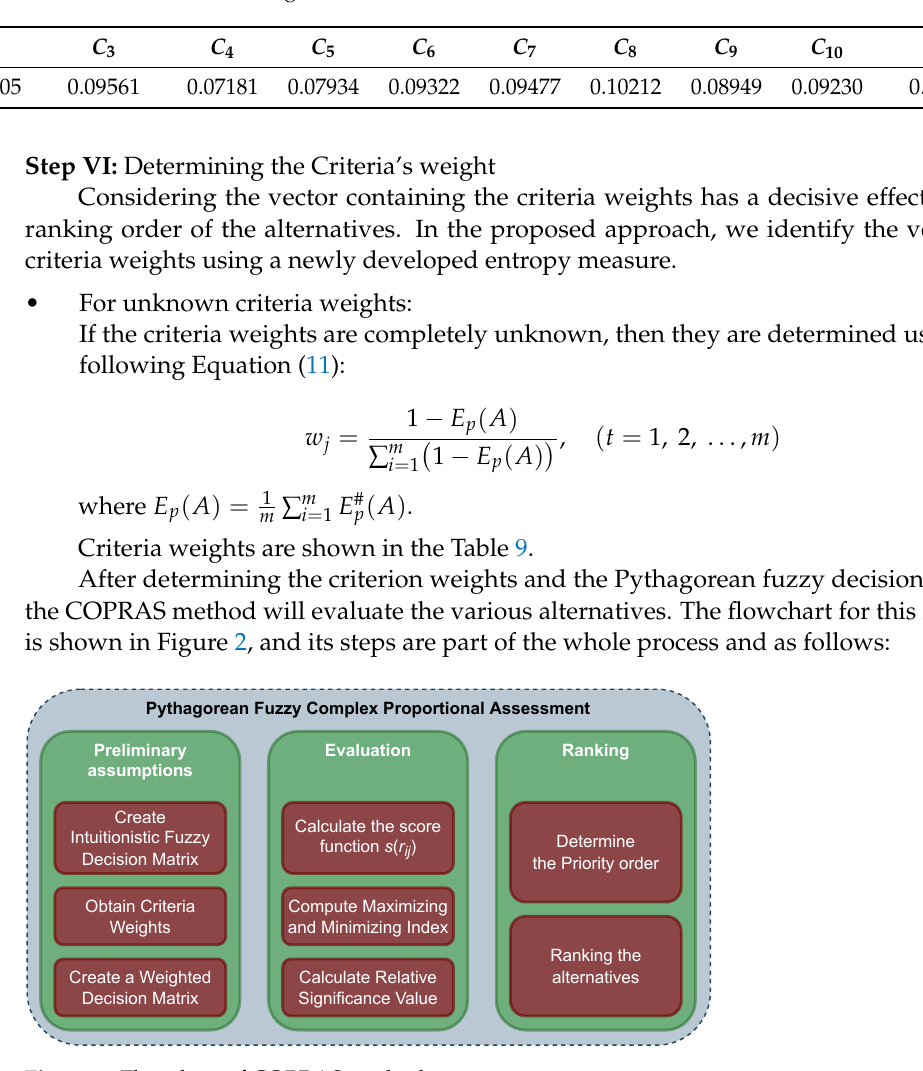
Table 9. Evaluation of weights of criteria.